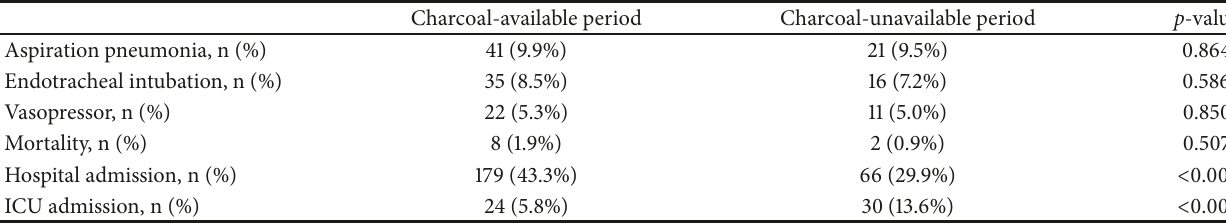
Table 3: Charcoal availability and clinical outcome. Charcoal-available period